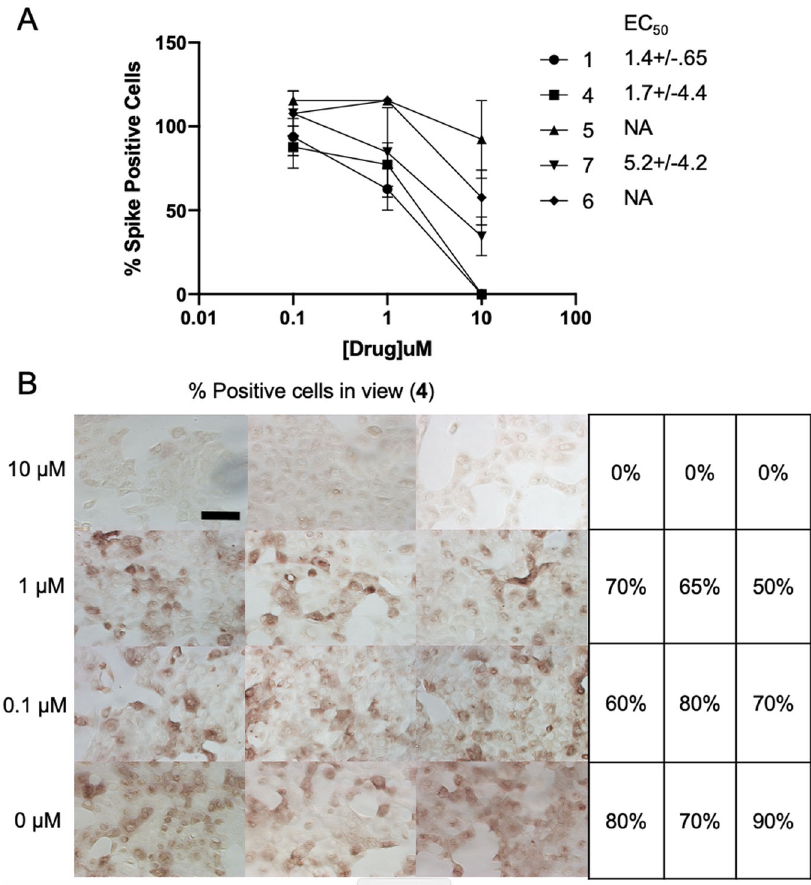
Fig. 3 Virus inhibition in whole cell assay. A Virus replication activity assays for compounds 1 , 4 , 5 , 6 , and 7 . Data are mean % percent spike positive cells relative to DMSO treated cells + / − SEM of three biological replicates. B whole cell assay for compound 4 . Percent Spike positive cells, n = 100. Scale bar is 100 μ